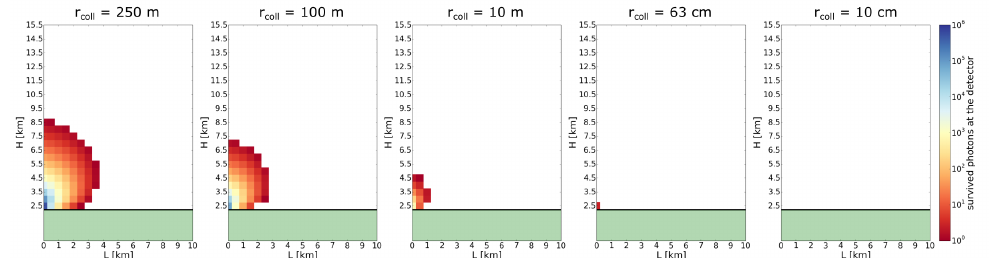
Figure 6. Detectability regions obtained from the analytical model. In the panels, the color of each ( L , H ) pixel represents the number of gamma-ray photons reaching a collecting area of radius r coll , survived from a TGF with N 0 = 10 10 initial gamma-ray seeds emitted in that ( L , H ) position. The black line with the green region indicates the separation with the ground surface on Mt. Cimone, at about 2165 m a.s.l.